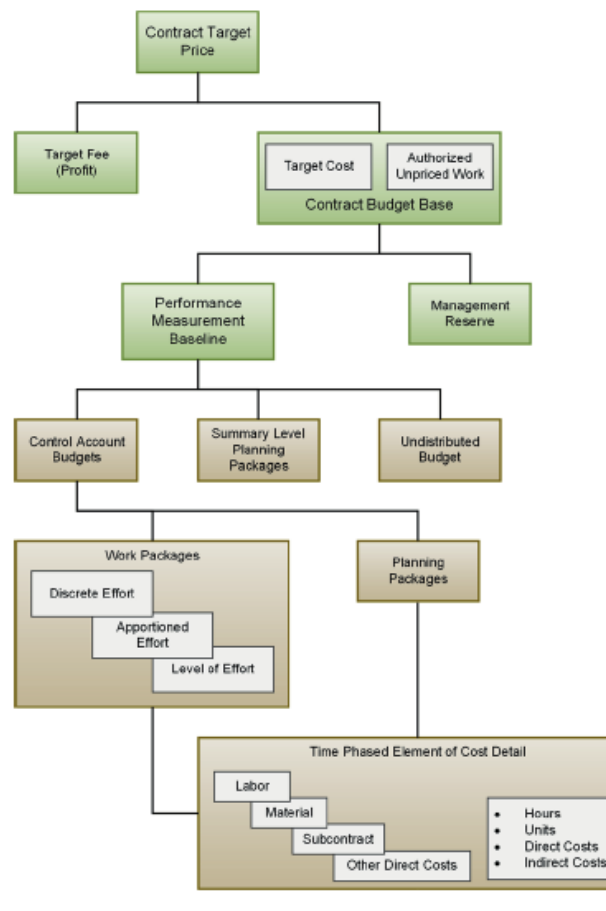
Fig. 5. Budget element hierarchy (NDIA IPMD, 2018: